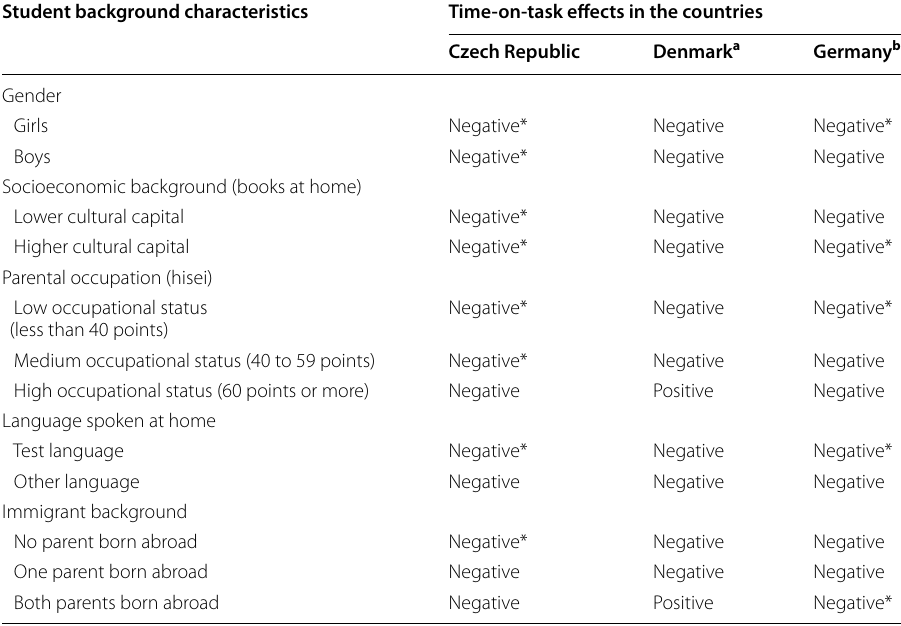
Table 9 Time-on-task effects regarding students’ background characteristics in the Czech Republic, Denmark and